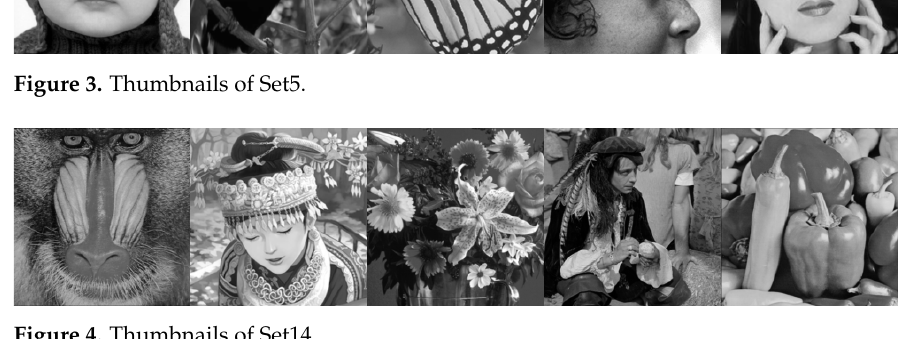
Figure 4. Thumbnails of Set14.